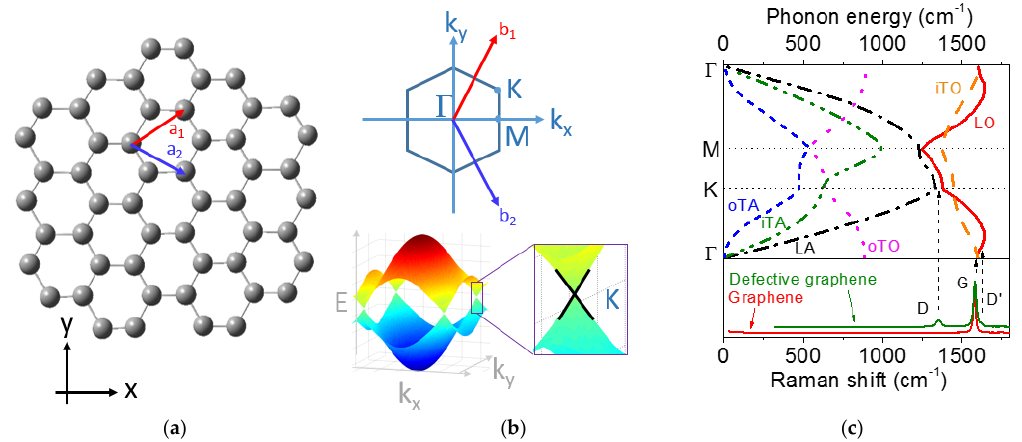
Figure 5. Honeycomb lattice of graphene. ( a ) Unit ‐ cell vectors (a1 and a2). ( b ) Electronic structure in the reciprocal lattice. Г , K , and M are high symmetry points in this space. ( c ) Phonon dispersion curve and Raman spectra ( LO , LA , iTO , iTA , oTO , and oTA . O and A refer to optic and acoustic phonon branches, L and T refer to longitudinal and transversal, and i and o refer to in plane or out of plane,